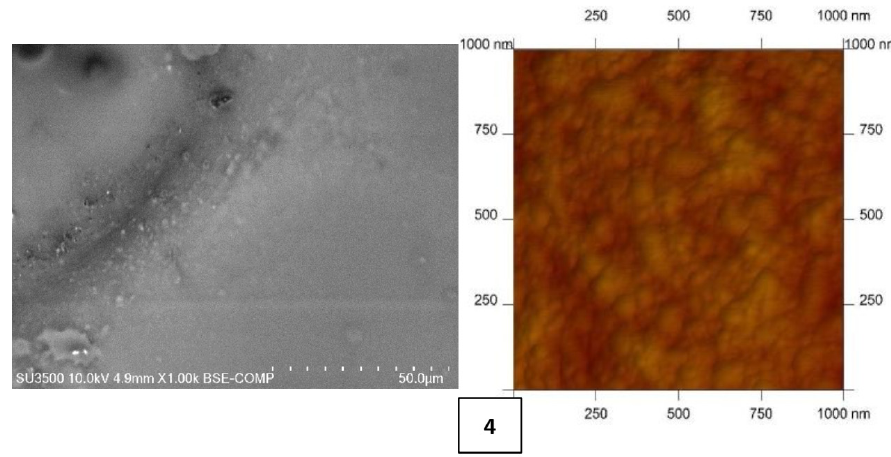
Figure 1. SEM and 2D AFM images of PIMs doped 2-methylimidazole ( 1 ), 2-ethylimidazole ( 2 ), 2-propylimidazole ( 3 ), and 2-butylimidazole ( 4 ).